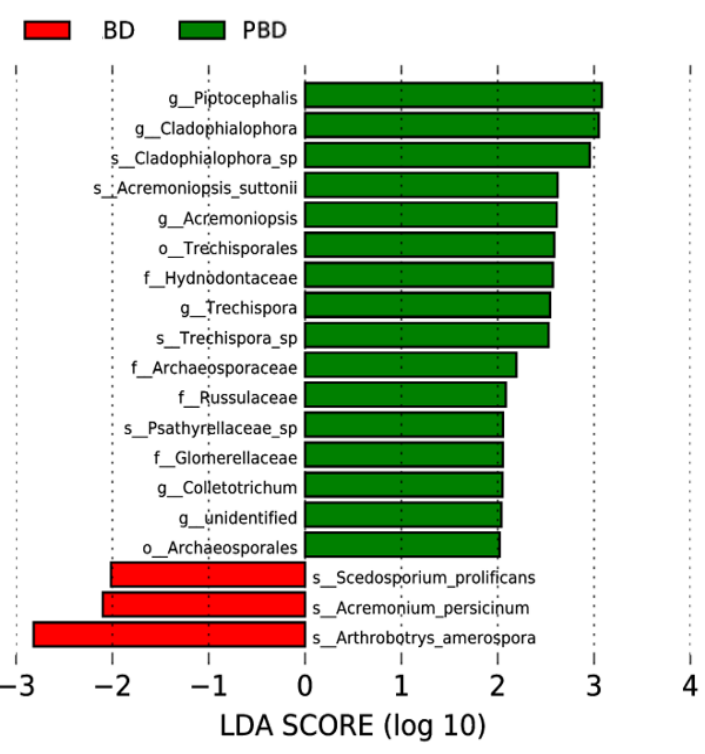
Figure A1. The indicator fungi with LDA scores > 2 in fungal communities were associated with different cover crops – biochar – organic fertilizer treatments.